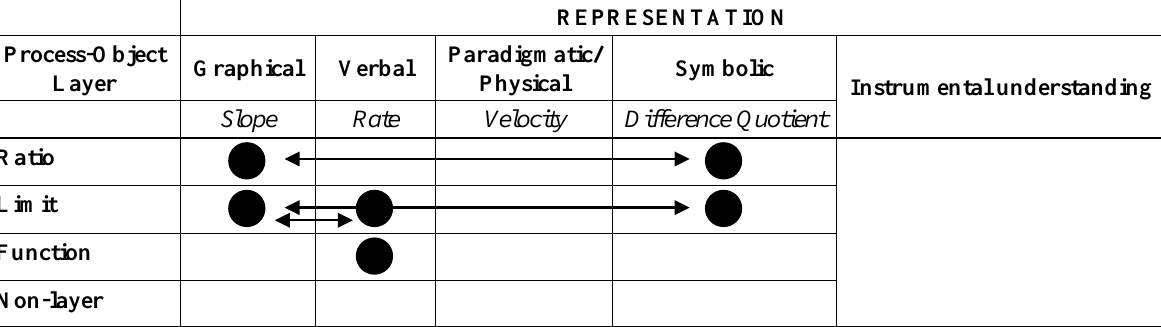
Figure 4: Deanne’s interpretation of the